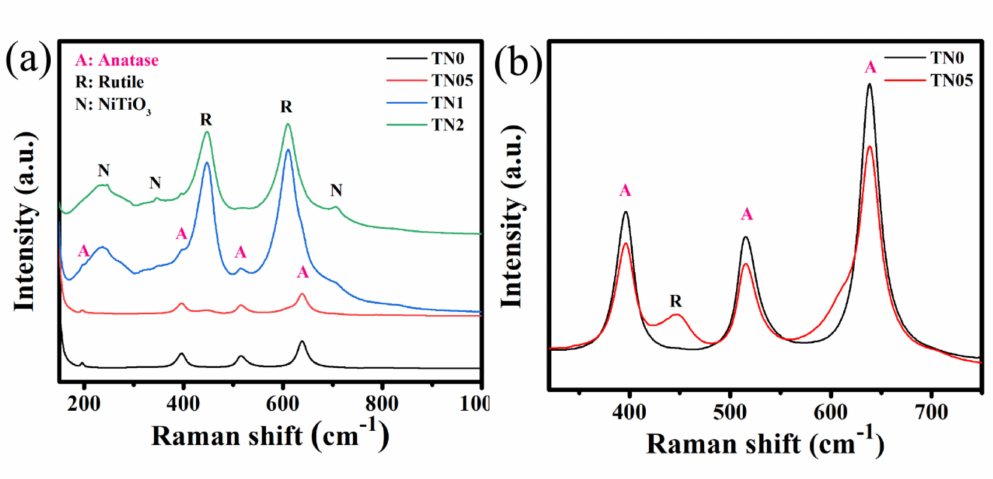
Figure 2. ( a ) Raman spectra of undoped and Ni-doped TiO 2 , ( b ) zoom in on main peaks of TN0 and